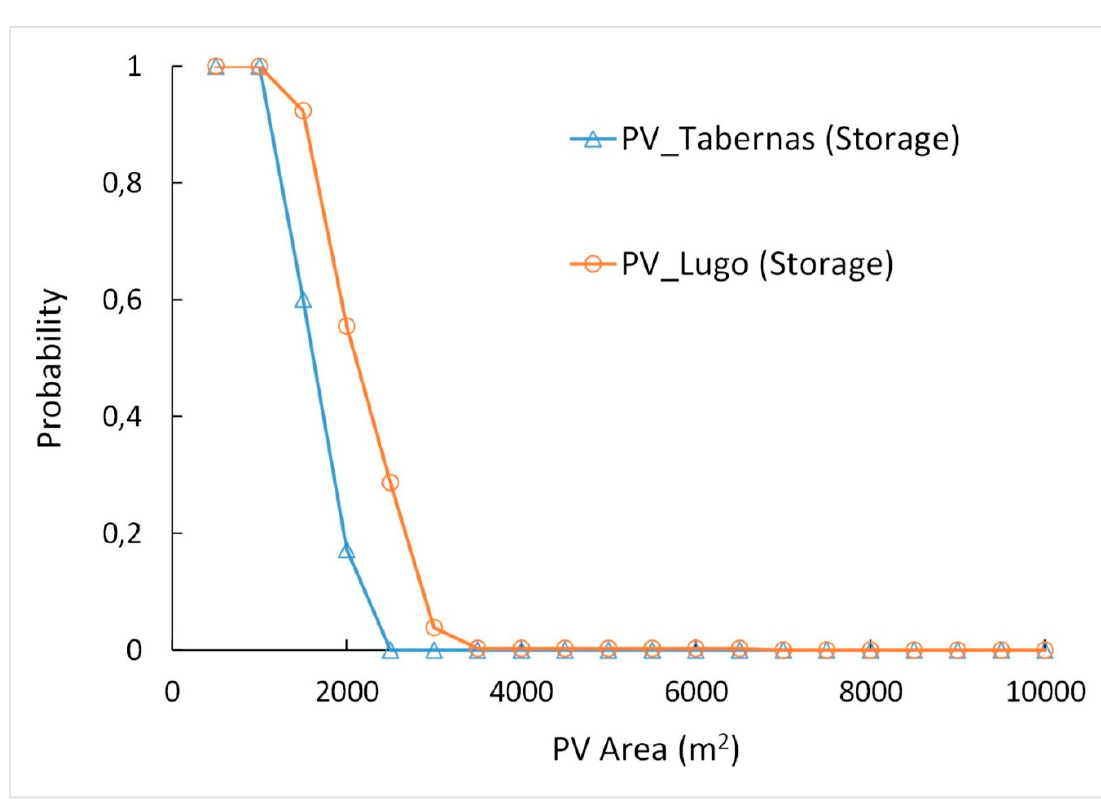
Figure 6. Probability of not meeting the energy consumption threshold considering storage.